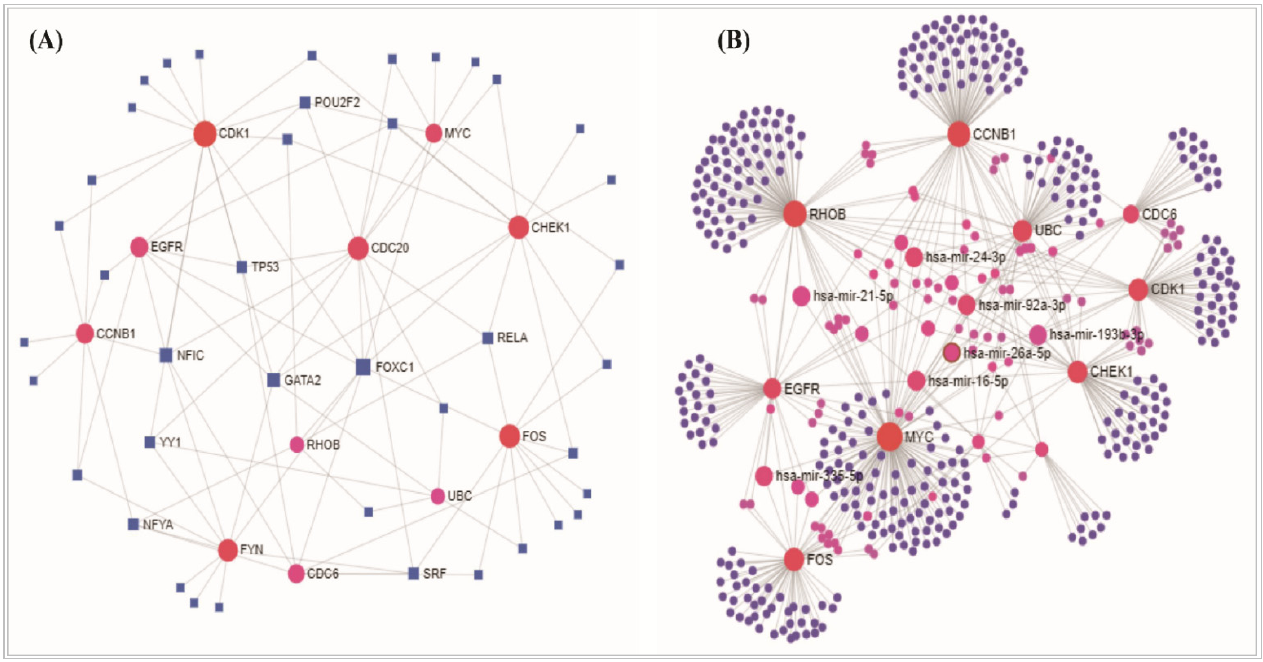
Figure 7. ( A ) The hub proteins–TFs interaction network, and the TFs are marked as blue-shaped square in the interactions. ( B ) The hub proteins–miRNA interaction network, and the hub proteins are marked as red circles in interaction network. The larger significant miRNAs are labeled and marked as pink-colored circles.